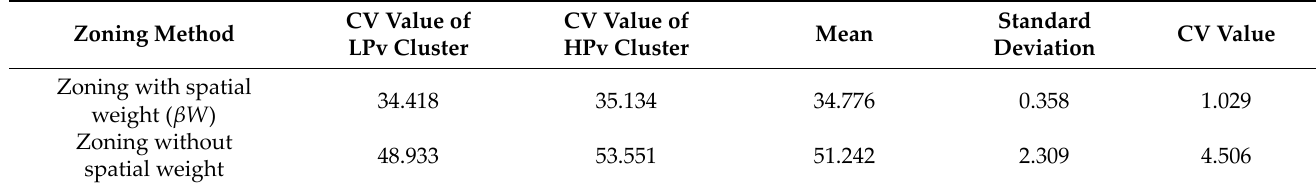
Table 5. The CV value of each cluster (LPv and HPv) and overall for each zoning method.